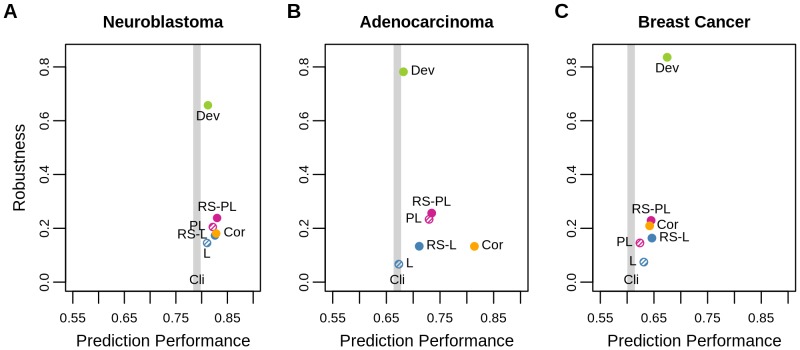
Prediction performance vs. robustness.Prediction performance in the median concordance index (x-axis) and robustness in the Jaccard index (y-axis) are shown respectively for neuroblastoma (panel A), adenocarcinoma (B), and breast cancer (C) data sets. Since no variable selection is performed for Cli, only its prediction performance is shown as vertical lines.